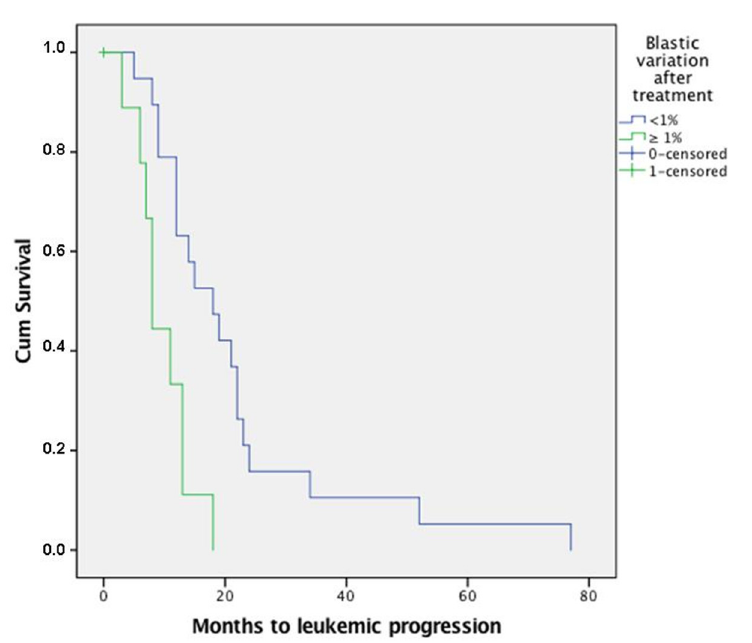
Figure 2. Progression to leukemic disease among patients with ≥ 1% increase in blast count after treatment occurred earlier than patients with no blast increase.